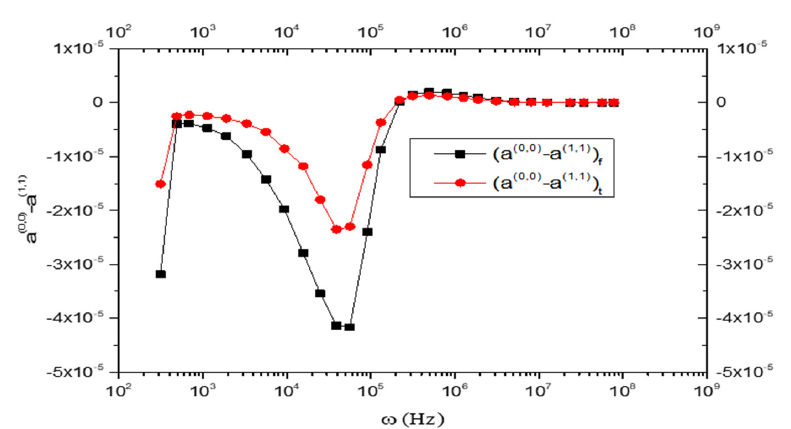
Figure 6. Comparison between the difference of state coefficients a (0,0) and a (1,1) in normal (black line) and cancerous cells (red line) as a function of frequency, see Equations (A15) and (A16).